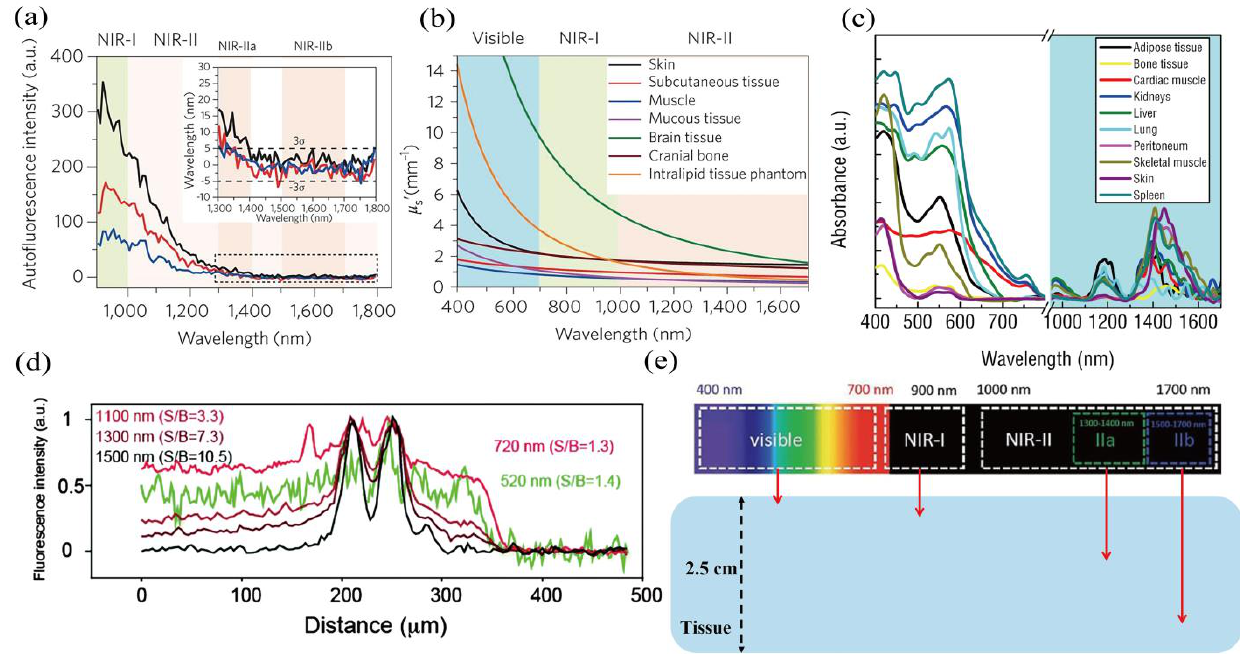
Figure 1. ( a ) Autofluorescence spectra of mouse liver (black), spleen (red), and heart tissue (blue) under 808 nm light. Inset shows the enlarged results at longer wavelengths. ( b ) Scattering coefficients of intralipid tissue phantoms and various biological tissues in the wavelength range of 400~1700 nm. ( a , b ) Adapted, with permission, from Ref. [14]. Copyright 2017, Springer Nature. ( c ) Absorbance spectra of various biological tissues. Adapted, with permission, from Ref. [15]. Copyright 2013, Springer Nature. ( d ) Line profile analysis of the fluorescence intensities in the lymph system of a mouse. The values of the S/B express signal to background ratios in the fluorescence intensities. Adapted, with permission, from Ref. [16]. Copyright 2014, Royal Society of Chemistry. ( e ) Schematic of the imaging depth in tissues for visible, NIR−I, and NIR−II light, respectively .